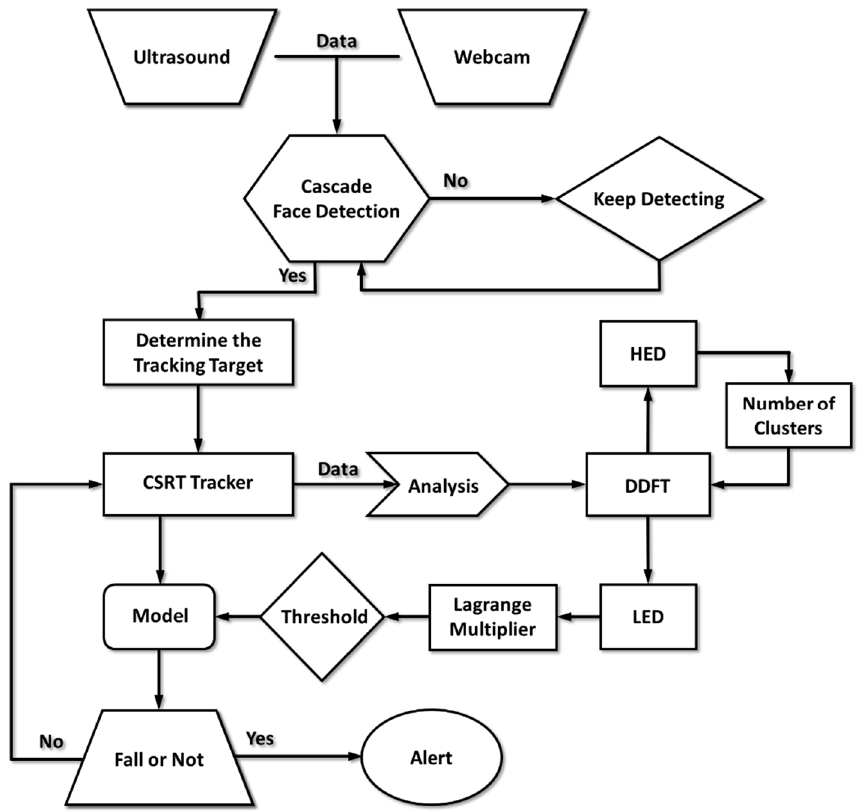
Figure 3. The systematic structure illustrates the stages of data collection, human detection and tracking, probability model training, and the trigger conditions of the fall alarm.